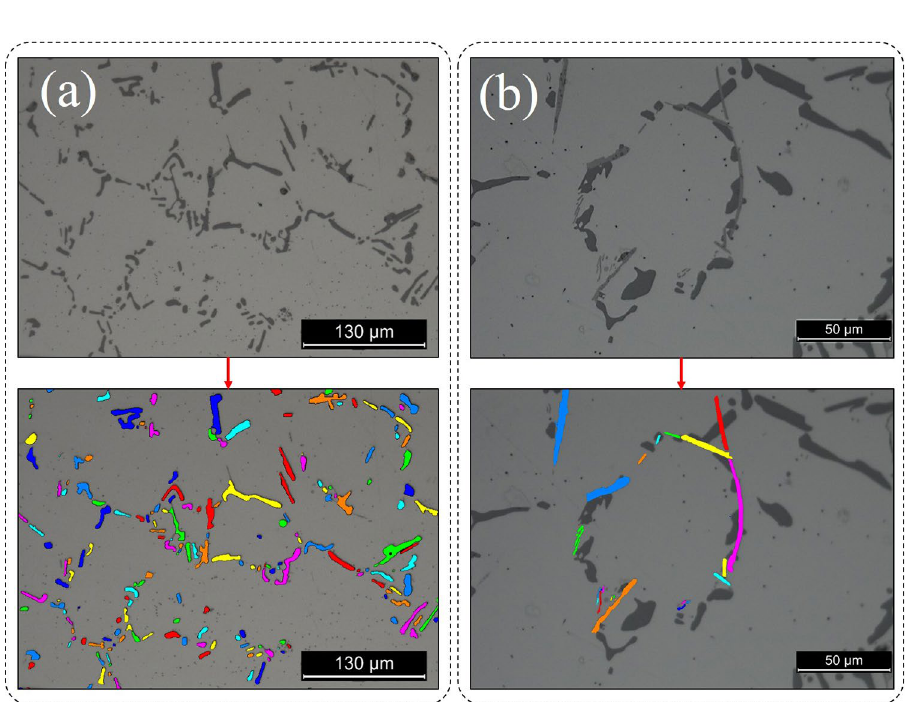
Figure 8. Detail of ( a ) partially spheroidised eutectic Si and ( b ) the needle shaped β-phase intermetallic compounds highlighted in the A356 Al lattice structures for a cell corner (see Fig. 6a). Note the thresholding colors were processed in Avizo Standard and do not portray the orientation of the secondary